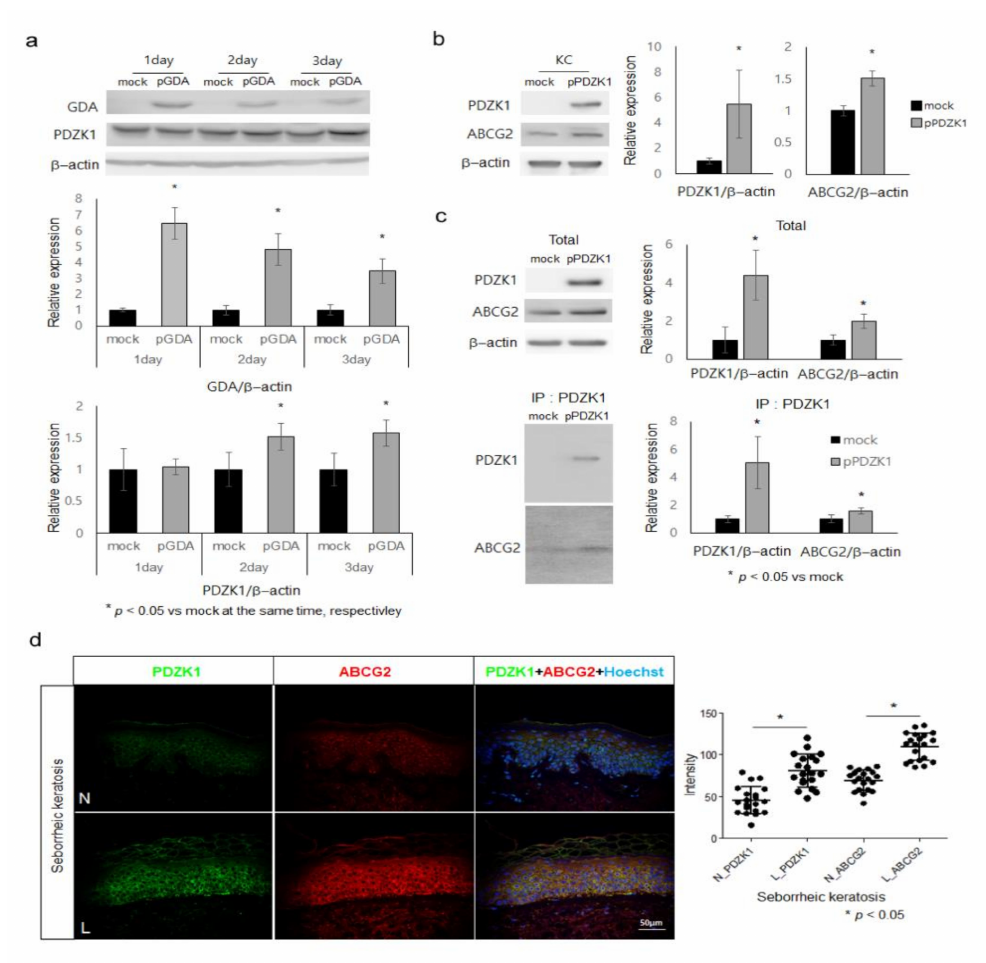
Figure 3. ABCG2 action is facilitated by PDZK1 in keratinocytes. ( a ) Western blot analysis for relative ratios of PDZK1 protein levels in keratinocytes after GDA overexpression. (b) Western blot analysis for relative ratios of ABCG2